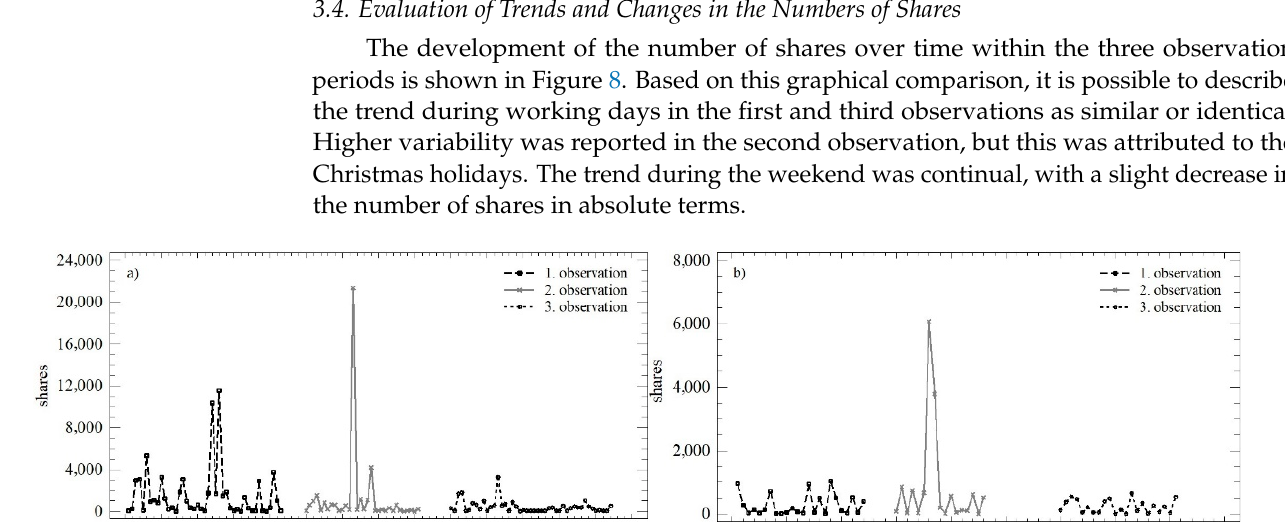
Figure 7. Density plot of the numbers of likes over the three monitored observation periods: ( a ) observation no. 1; ( b ) observation no. 2; ( c ) observation no. 3.